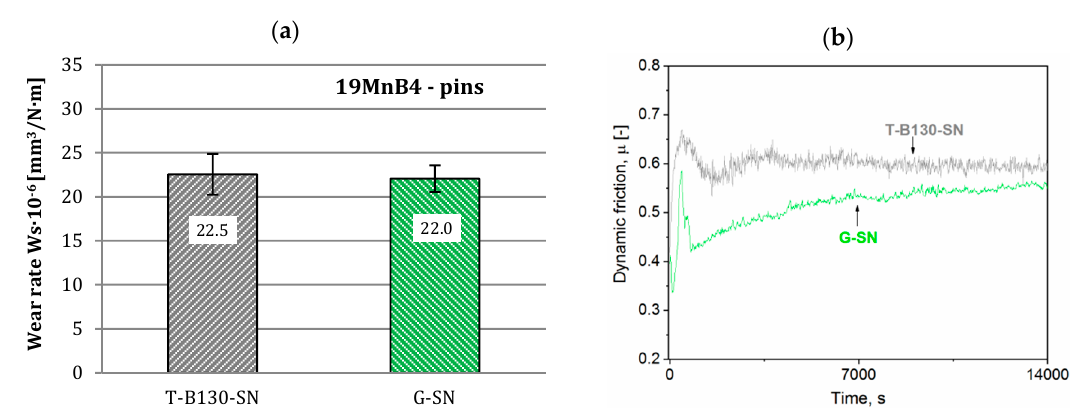
Figure 13. Wear rates ( a ) and dynamic friction ( b ) values for Vancron 40 steel after G-SN and T-B130-SN; 19MnB4 steel pins as counterbodies were used.